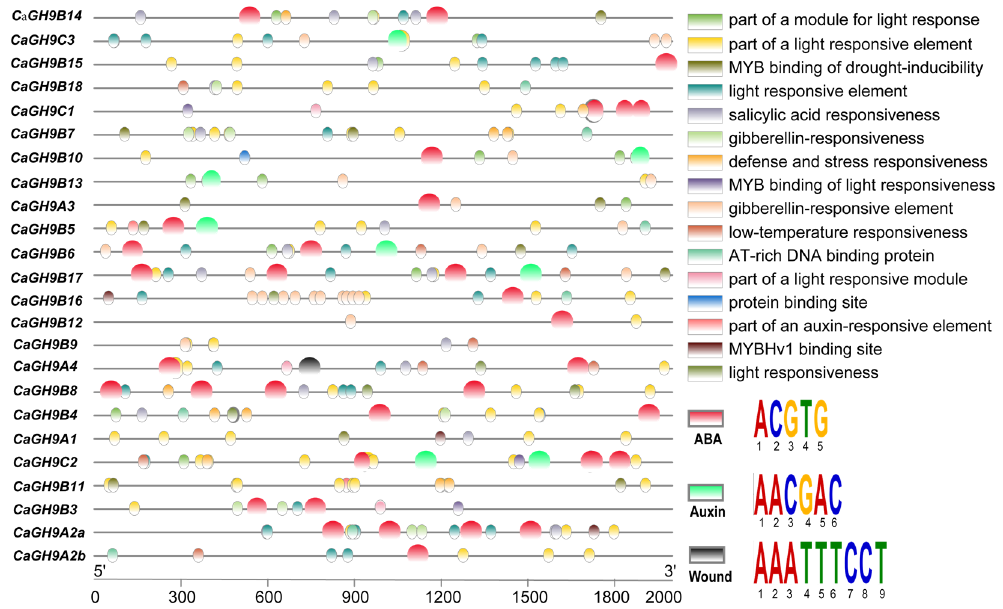
Figure 5. Distribution of cis-elements in the promoter region of GH9 family genes from pepper ( Capsicum annum ). The black, green and red balls represent wound-, auxin- and ABA-responsive element, respectively. These elements are potentially involved in grafting healing, and the wound- and auxin-responsive elements are missing in the promoter of CaGH9B3